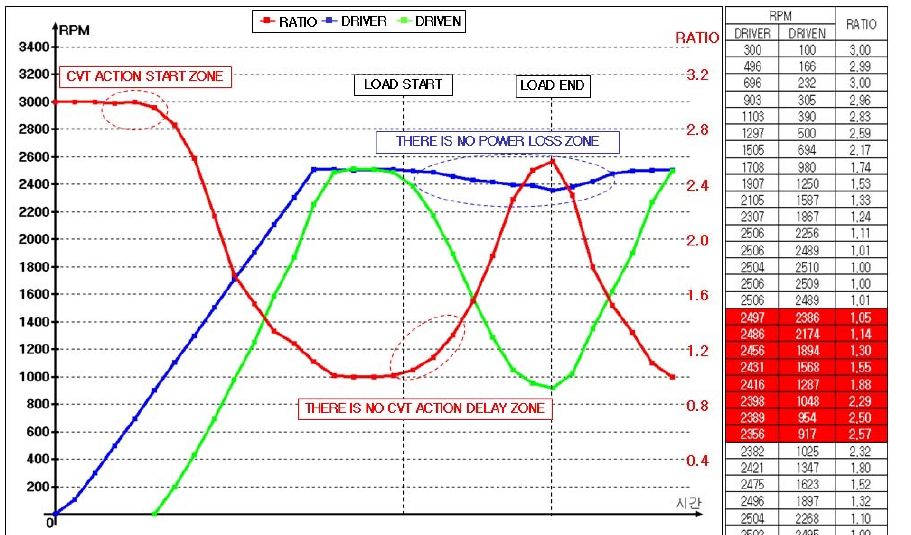
Figure 18. CVT data.